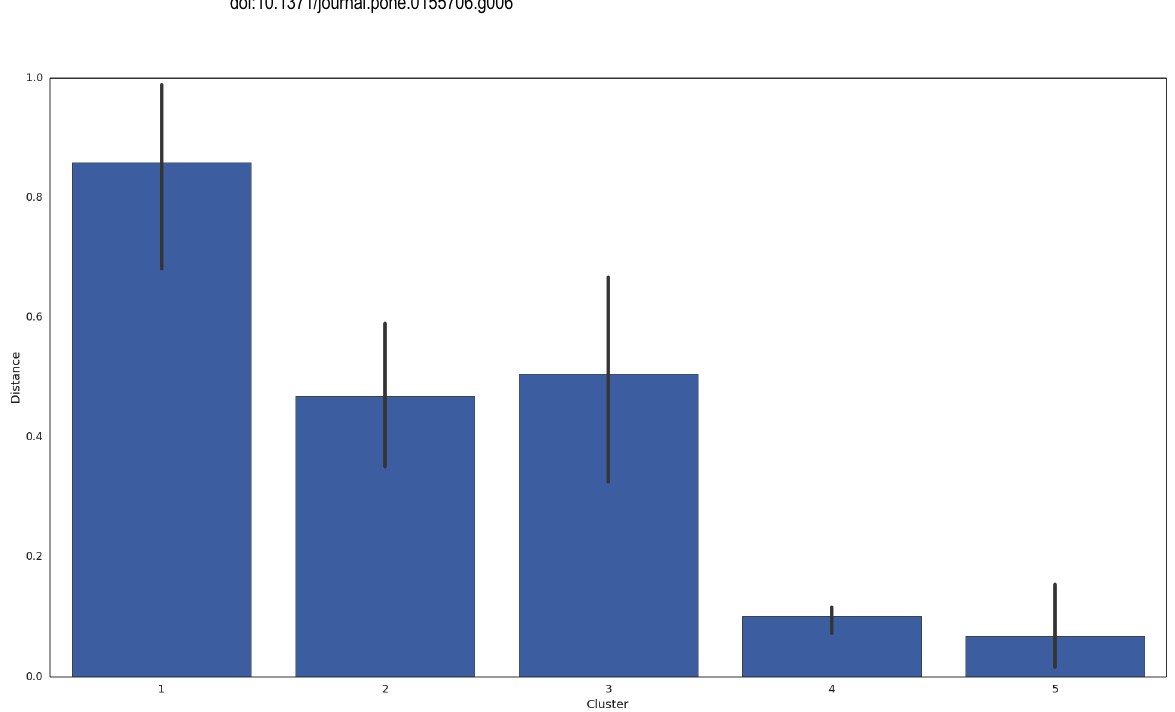
Fig 7. Estimated Hamming Distance Between Simulated and Realized Data by Cluster. Vertical bars reflect the Standard